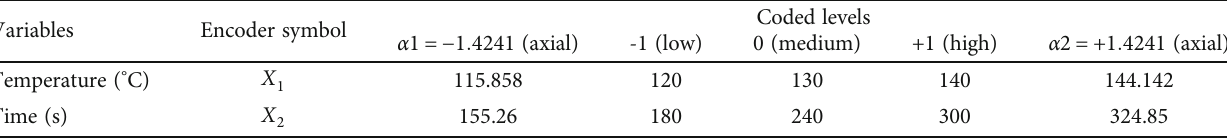
Table 1: Rotational composite central design matrix (CCD-R) with axial points and coded center points: vacuum frying. Variables